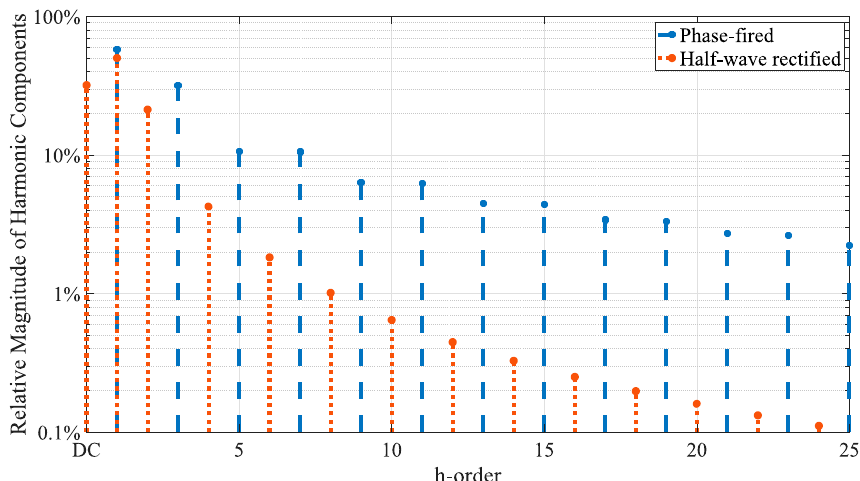
Figure 2. Odd and even harmonic disturbance tests waveforms magnitude spectra defined in EN 50470-3 and IEC 62053-21.